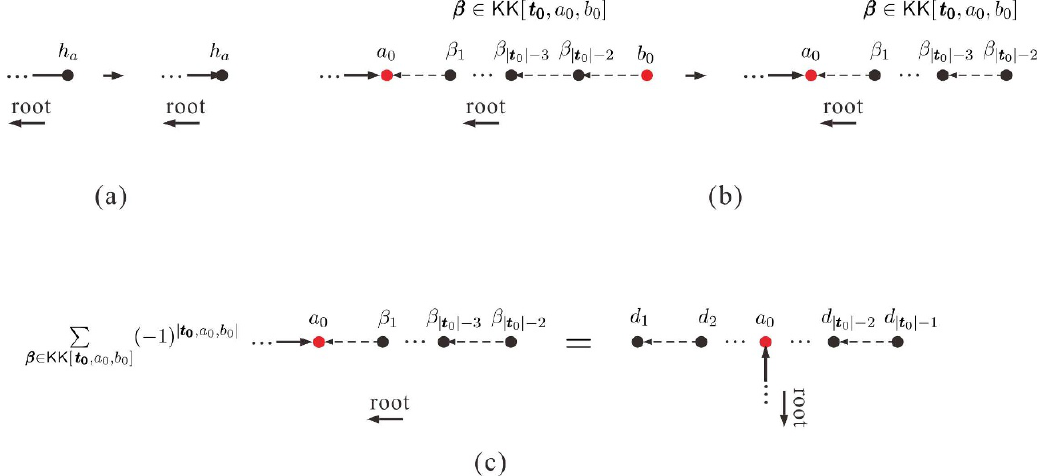
Figure 5 . The induced identities (2.19) and (2.21) are obtained respectively by imposing the replacements (a) and (b) on the graphs in eq. (2.1) where the corresponding highest-weight elements are the graviton h a and the trace ttt 0 . The sum over all (cid:12)(cid:12)(cid:12) 2 KK [ ttt 0 ; a 0 ; b 0 ] (with the sign ( (cid:0) 1) j ttt 0 ;a 0 ;b 0 j ) on the r.h.s. of the replacement (b) can be further expressed by (c), where the full trace t t t 0 is